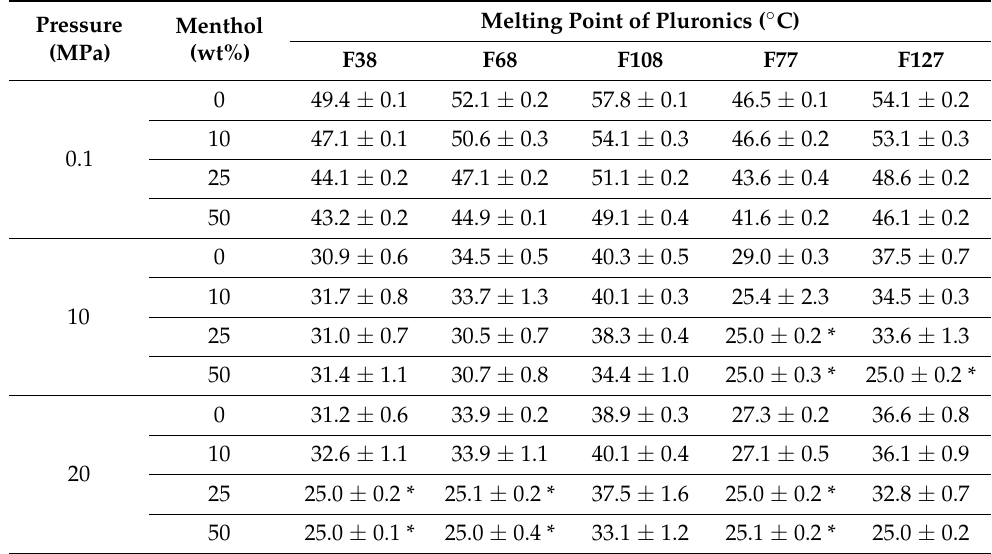
Table 3. Melting points of Pluronics and polymer/menthol mixtures at 0.1, 10, and 20